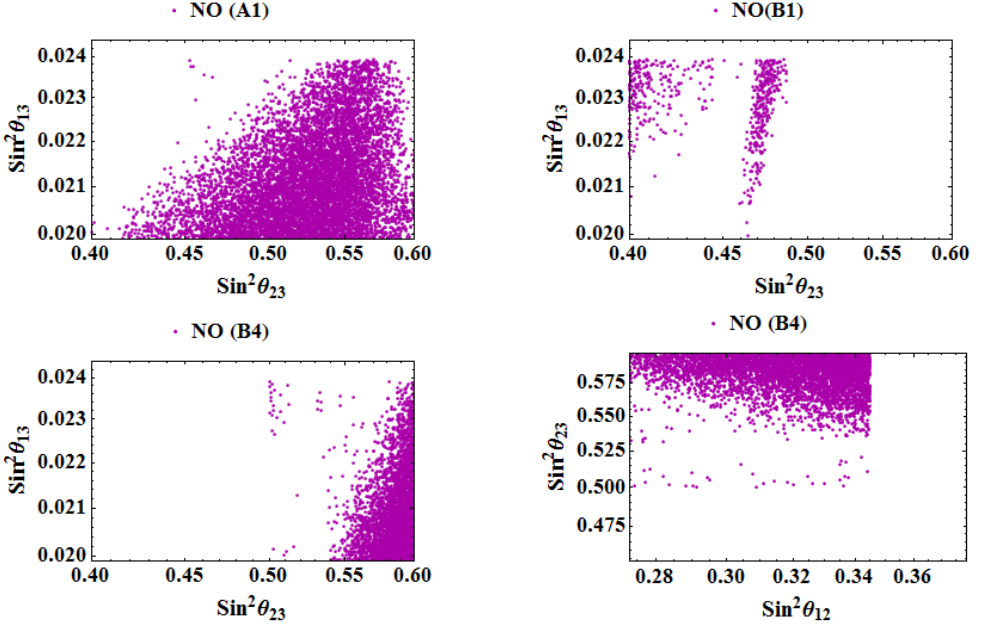
Figure 6 . Correlation between neutrino parameters in NO case.